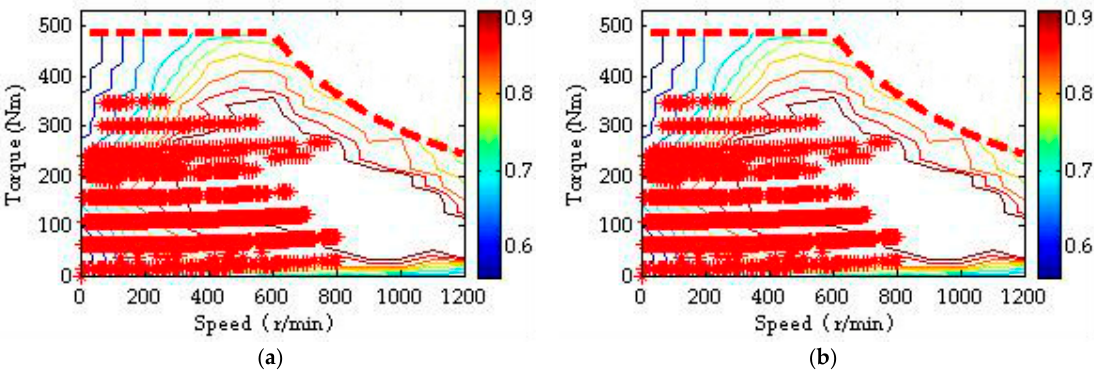
Figure 14. Operating points for ( a ) the front-axle motors and ( b ) the rear-axle motors under the case of BSBC and constructed driving cycle.